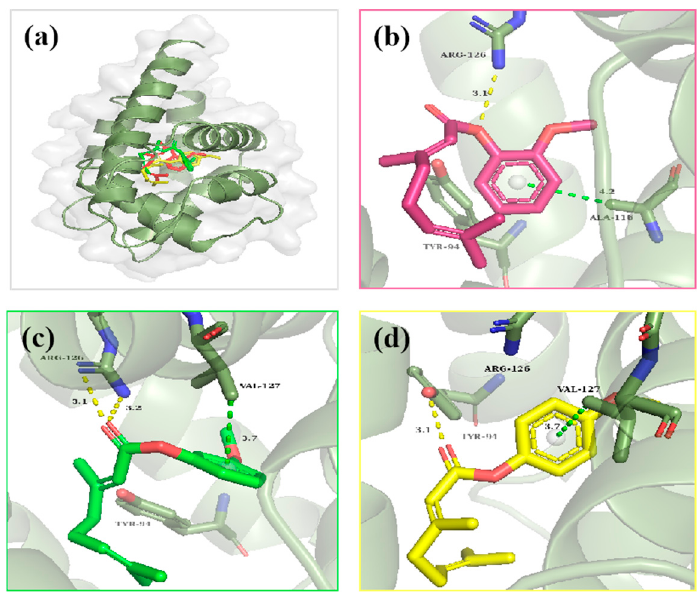
Figure 6. ( a ) Superimposed conformations of the molecular docking ligands; ( b ) The docking conformation of 5e ( ortho- ); ( c ) The docking conformation of 5f ( meta- ); ( d ) The docking conformation of 5g ( para- ).